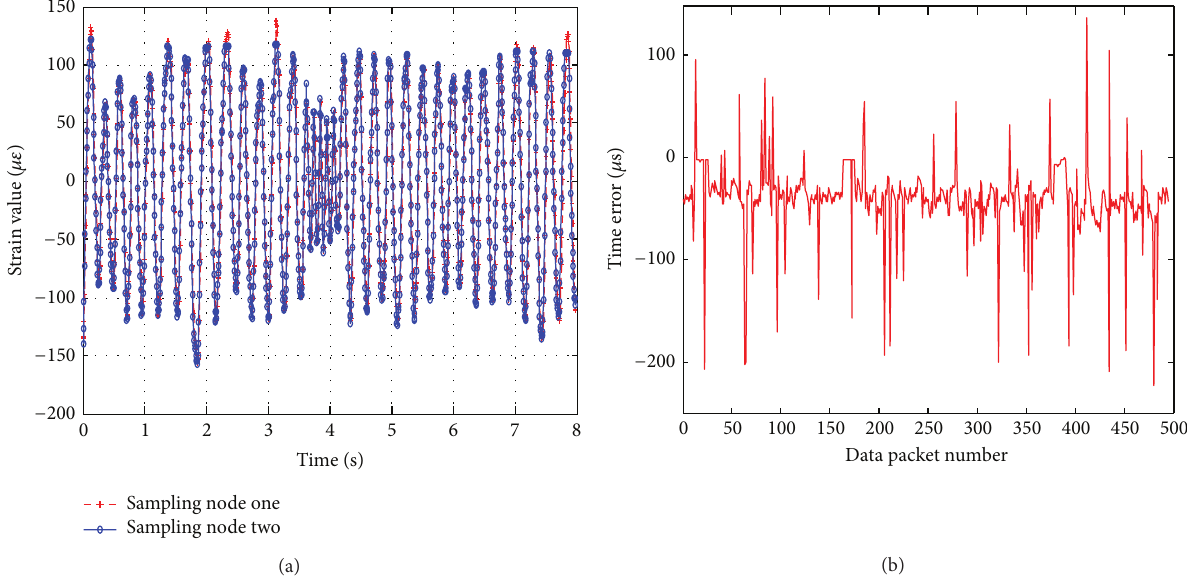
Figure 18: Time synchronization error of 64Hz: (a) time history signal and (b) time error.